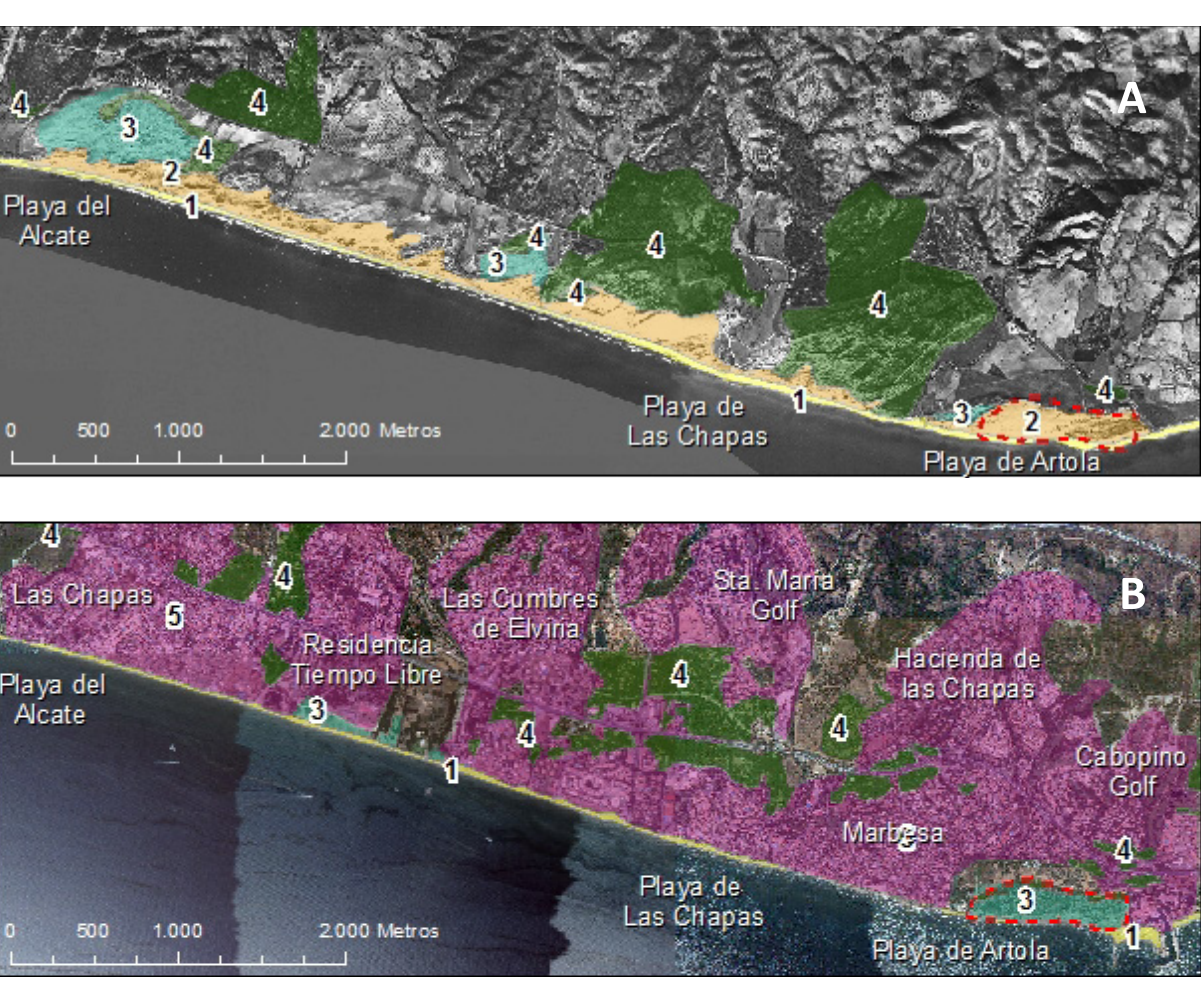
Figure 3. Vegetation map of Marbella (Málaga) 1956 (A) and 2013 (B). The discontinuous red lines indicate the protected natural space. 1, Beach and the halo-nitrophilous communities; 2, Mobile dunes; 3, Semi-fixed dunes; 4, Stable dunes; 5,